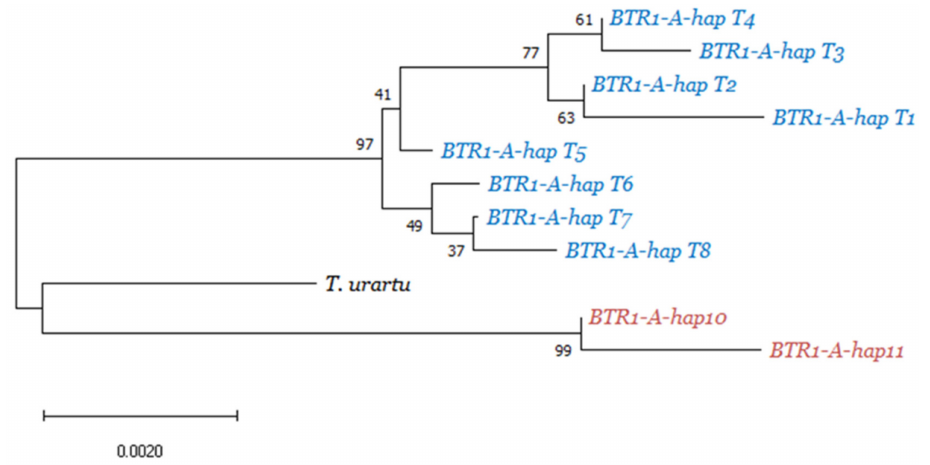
Figure 2. Phylogram based on BTR1-A variants showing clear differentiation between the T. turgidum (red) and T. timopheevii (blue) species, relative to the diploid T. urartu paraphyletic outgroup. The phylogram illustrates the close relationship between T. araraticum haplotype BTR1-A-hapT7 and domesticated timopheevii haplotype BTR1-A-hapT8 . Local bootstrap values after 1000 replicates are indicated at the